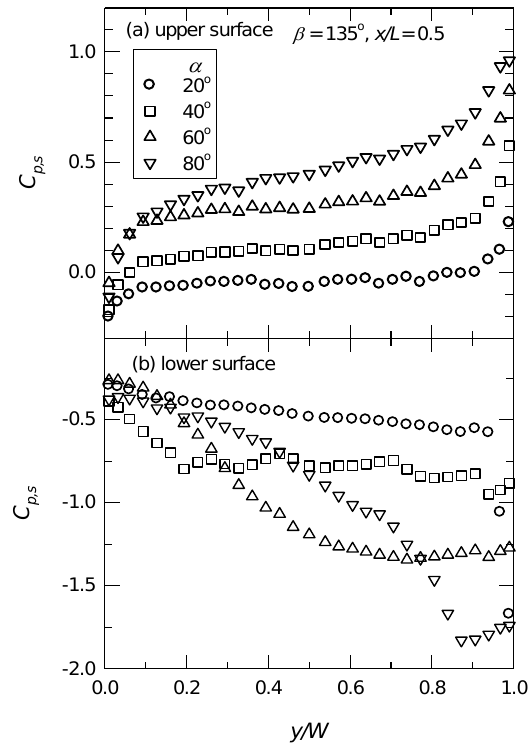
Figure 9. Mean spanwise pressure distributions for x/L = 0.5 and β = 135°.